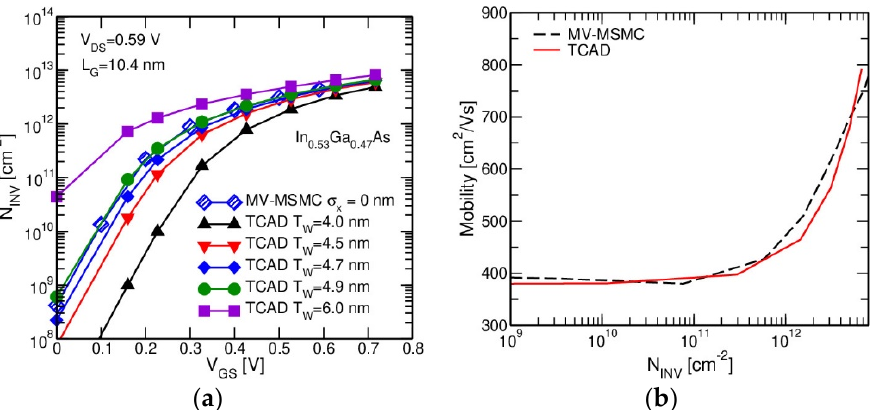
Figure 11. ( a ) N INV vs. V GS for V DS = 0.59 V comparing TCAD (Technology Computer Aided Design) (closed symbols) with different T W calibrated against MV–MSMC (diamonds) simulations. ( b ) Comparison of the low-field mobility between MV–MSMC (dashed line) and calibrated TCAD (solid line).